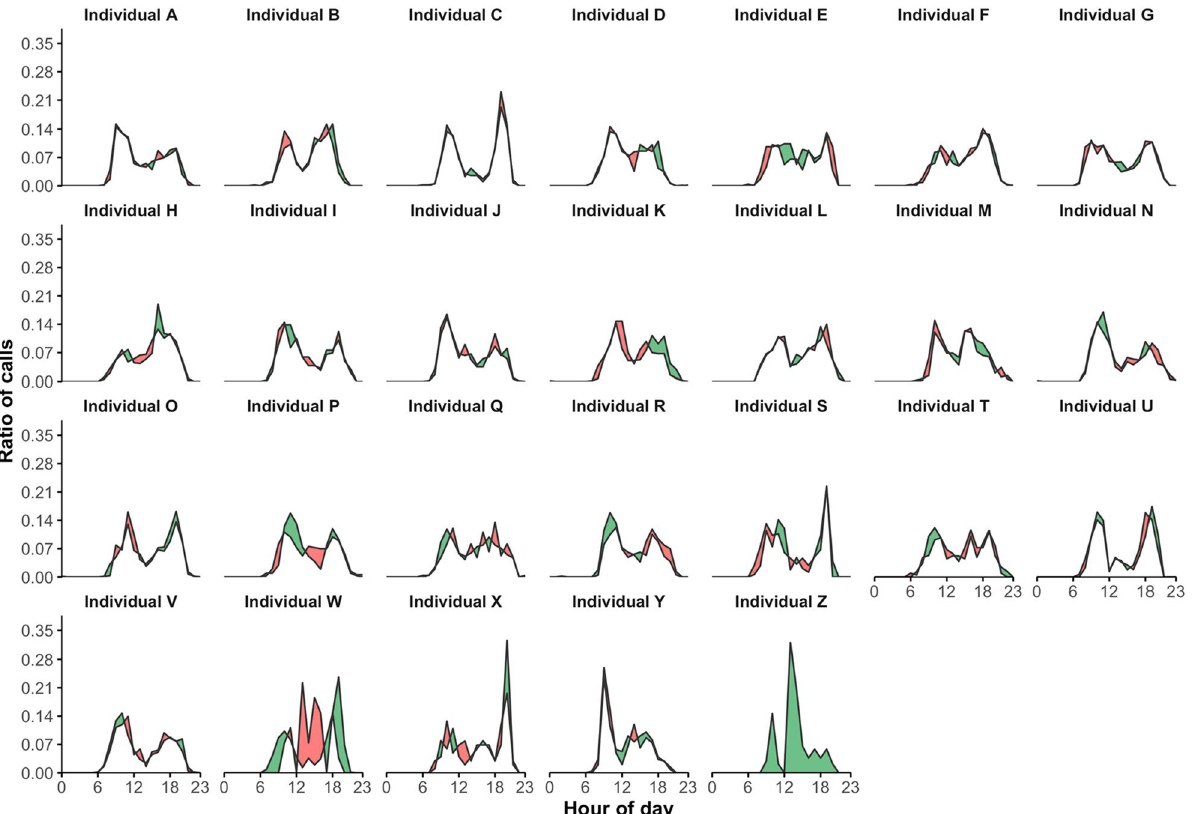
Figure 3. Comparison of two daily rhythms of incoming telephone call activity. Daily rhythms of incoming telephone call activity are calculated for the two successive time periods of 6 months each, T 1 and T 2 . Their differences are illustrated by coloring the area between the two corresponding curves: (1) in green when the ratio of calls corresponding to T 1 is higher than T 2 , and (2) in red for the